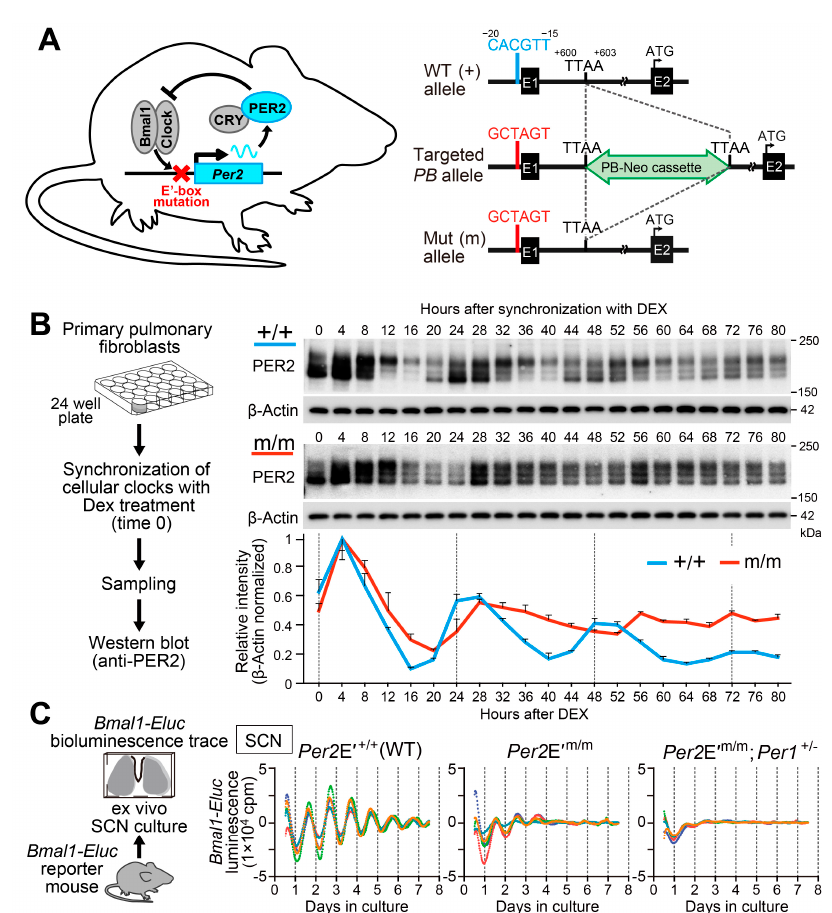
Figure 2. Targeted disruption of Per2 E ′ -box leads to unsustainable gene expression rhythms in organotypic SCN slices and cultured lung fibroblasts. ( A ) Generation of Per2 E ′ -box mutant mice. The CACGTT Per2 E ′ -box was mutated to GCTAGT using the piggyBac transposon system. Numbering shows the position relative to the putative transcription start site (+1). E1, exon 1; E2, exon 2; Green, piggyBac transposon carrying a neomycin-resistant gene (PB-Neo cassette) inserted at a genomic TTAA site (+600 to +603). ( B ) Temporal profiles of PER2 protein expression in Per2 E ′ +/+ and Per2 E ′ m/m lung fibroblasts. Representative immunoblots and normalized densitometry values ( n = 3, mean ± s.e.m.) are shown. ( C ) Bmal1-Eluc bioluminescence traces of ex-vivo SCN cultures from Per2 E ′ +/+ ( n = 5), Per2 E ′ m/m ( n = 5), and Per2 E ′ m/m ; Per1 +/ − ( n = 5) mice. Averaged de-trended data are shown. All tested SCN slices from Per2 E ′ -box mutant mice displayed attenuated luminescence rhythms, which were damped within 2–3 cycles. The residual damping rhythms were dependent on Per1 , because the luminescence from SCN slices of Per2 E ′ m/m ; Per1 +/ − mice exhibited even fewer persistent rhythms. Data in ( B ) and ( C ) are reproduced from [29].